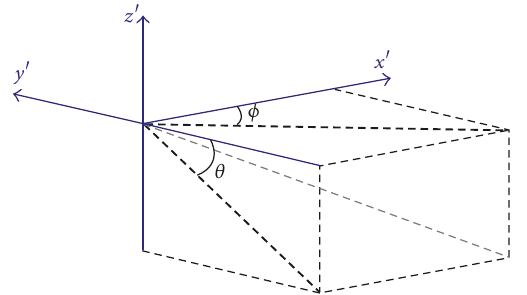
Figure 7: Definition of the angles used in the effective area calculation. The grey dashed line represents the orientation of one of thegeneratedvectors.Thepolarangle 𝜃 ismeasuredbetweenthe −𝑦 󸀠 axis direction and the projection of each vector in the 𝑦 󸀠 - 𝑧 󸀠 plane; it has values equal to or greater than 𝜋/2 . The azimuthal angle 𝜙 is measured between the 𝑥 󸀠 axis direction and the projection of the vectors in the 𝑥 󸀠 - 𝑦 󸀠 plane; it ranges from 0 to 𝜋 .